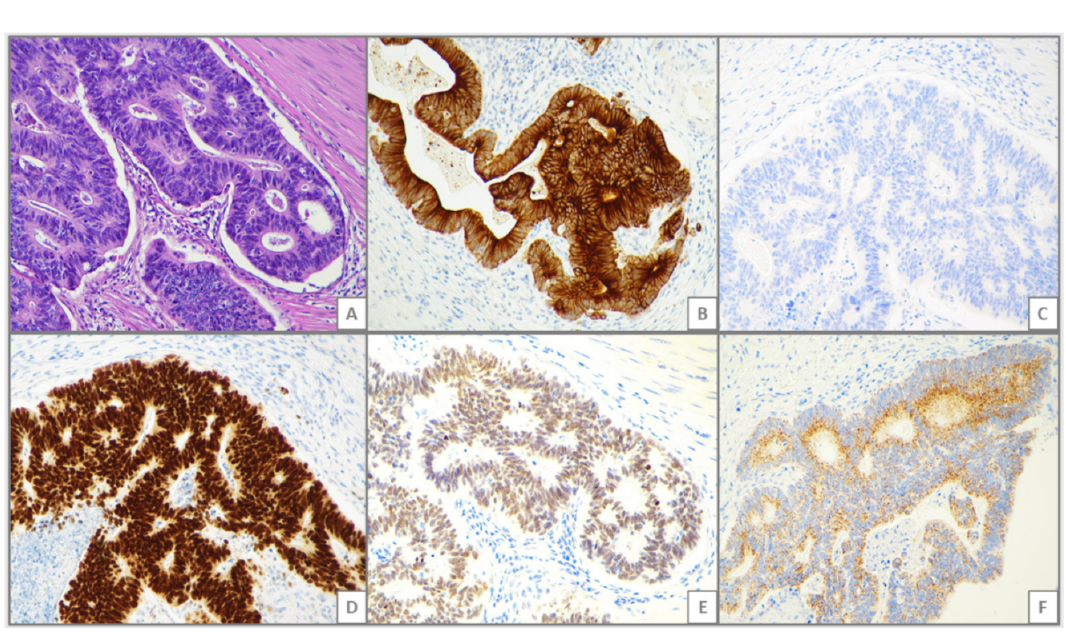
Figure 1. Representative histologic images of a small bowel adenocarcinoma (SBA) showing a full-blown colorectal cancer-like immunophenotype. ( A ) hematoxylin and eosin staining, showing a glandular-type SBA with well-formed glandular structures; ( B ) Cytokeratin (CK)20 immunohistochemistry, showing a strong and di ff use cytoplasmic reactivity for CK20; ( C ) CK7 immunohistochemistry, showing negativity for CK7 ( D ) Caudal type homeobox 2 (CDX2) immunohistochemistry, showing positivity for CDX2; ( E ) Staining for special AT-rich sequence-binding protein 2 (SATB2), showing SATB2 positivity; ( F ) Alpha-methylacyl-CoA racemase (AMACR), immunohistochemistry, showing AMACR tumor cell positivity. Original magnification: